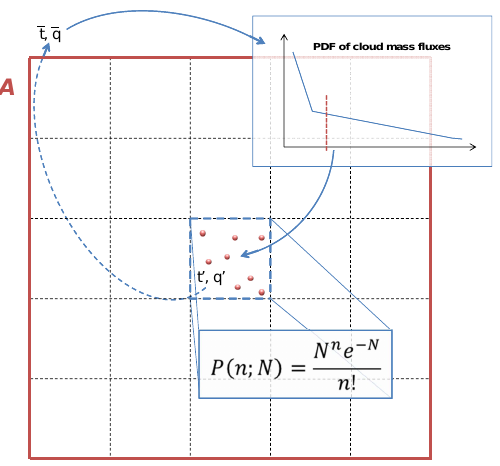
Figure 5. Histograms of the fractional cloud cover at the 700m height level for the different horizontal resolutions of the LES coarse graining.